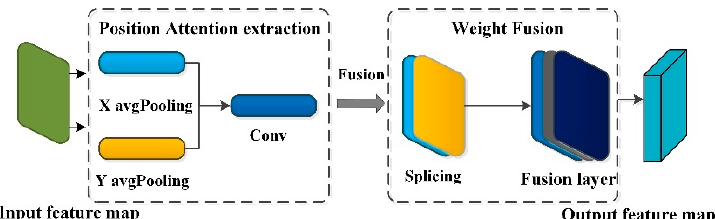
Figure 3. Position-wise attention mechanism.